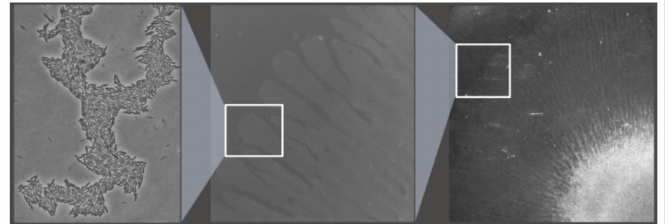
Figure 3. A multicellular B. amyloliquefaciens MBI600 community forms a biofilm in (M9) minimal media (A) but exhibits swarming motility when a synthetic analog of the root exudate malic acid (Merck) is added to the